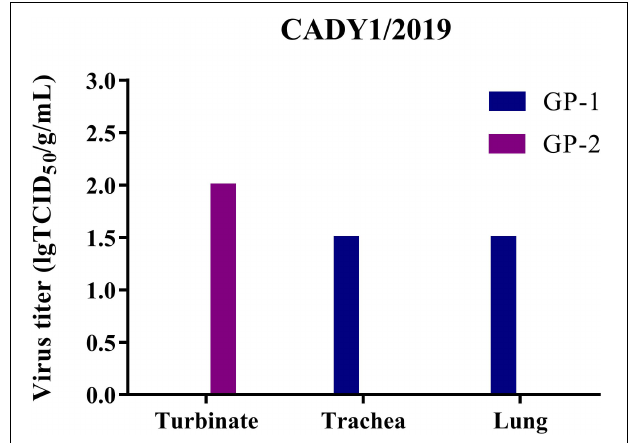
FIGURE 5 | The virus titers in different tissues of guinea pigs in CADY1/2019 inoculation group. Four guinea pigs were inoculated intranasally at a dose of 10 6 TCID 50 of CADY1/2019 or 47/2020 in 300 µ L. At 3 dpi, two infected guinea pigs in each virus experimental group were euthanized and turbinates, tracheas and lungs of them were collected for virus titration in MDCK cells. 47/2020 did not replicate in respiratory tissues of guinea pigs.